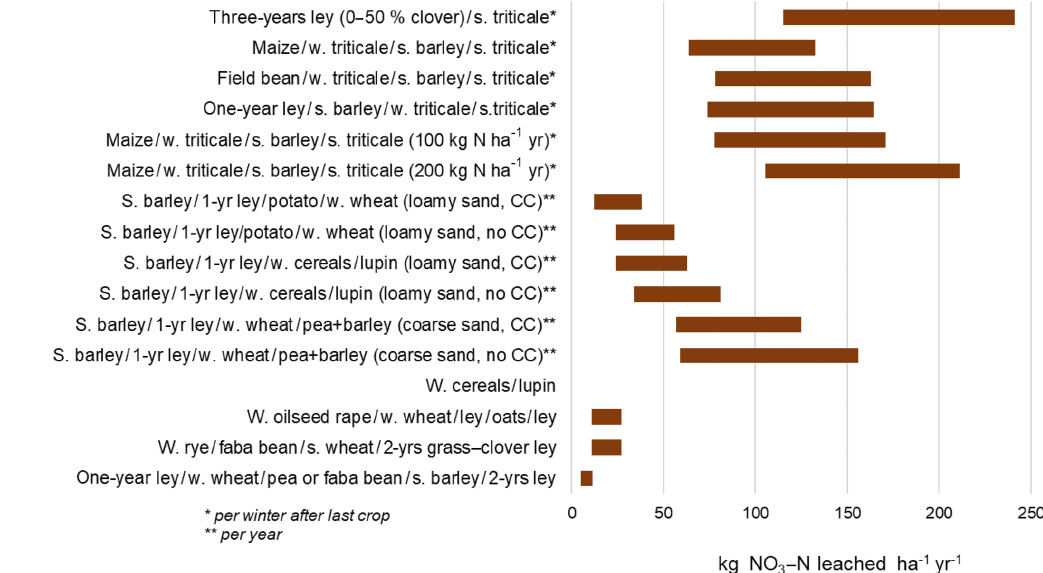
Figure 3. Lower and upper level of NO 3 leached (kgNO 3 –Nha − 1 yr − 1 ) in various field investigations: with or without a cover crop (CC), different amounts of N applied, and with or without grass–clover ley. “s.” refers to summer, and “w.” refers to winter. The data used are given in Table